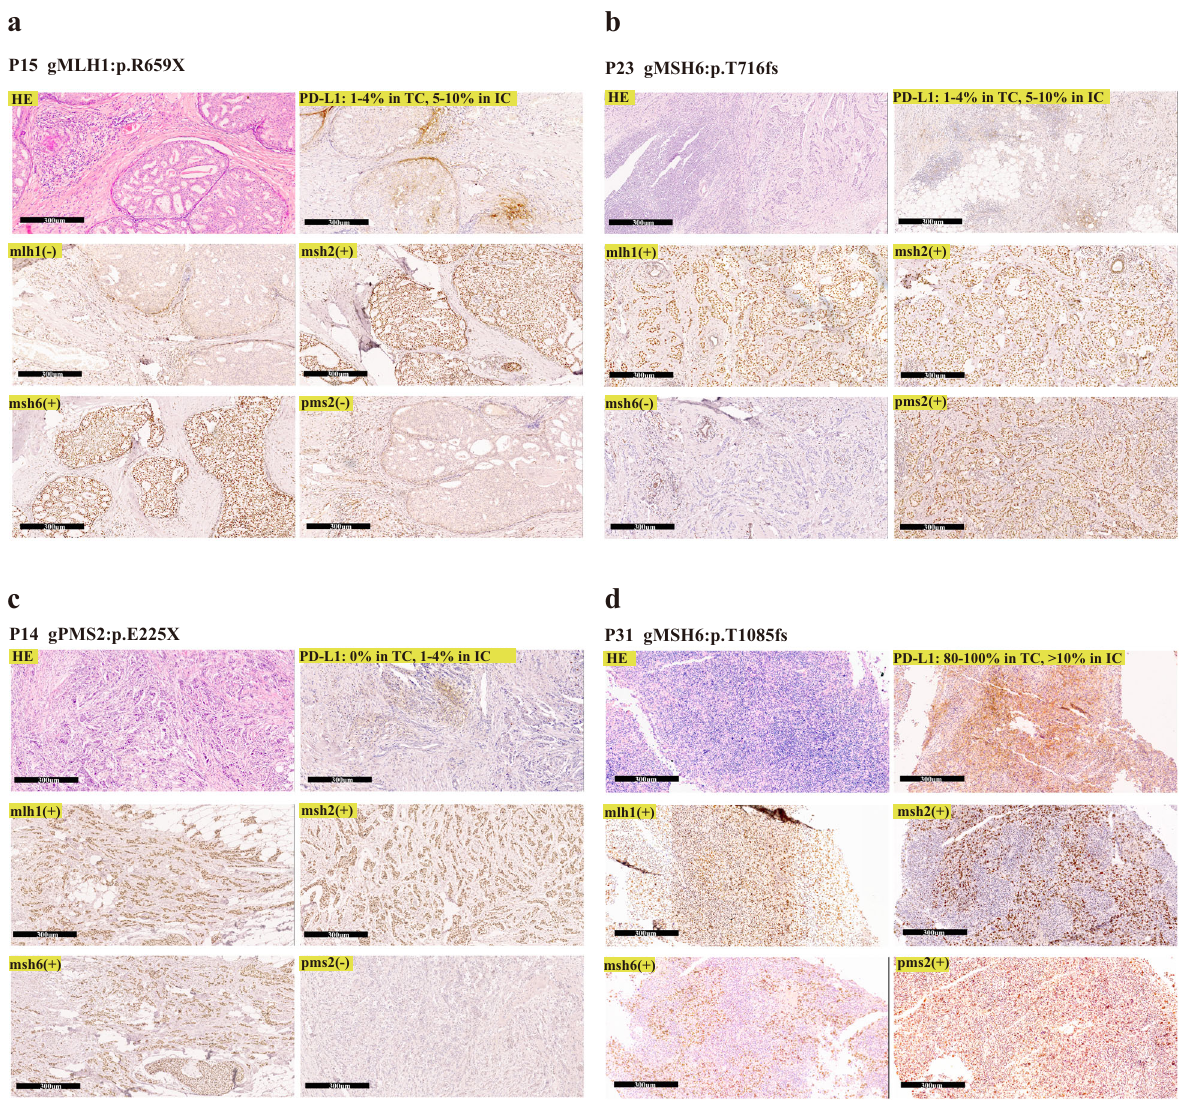
Fig. 2 H&E, PD-L1 protein and MMR protein immunostaining of breast cancers from MMR variant carriers. a MLH1 variant carrier, mlh1 and pms2 protein loss; b MSH6 variant carrier, msh6 protein loss; c PMS2 variant carrier, pms2 protein loss; d MSH6 variant carrier, strong pd-l1 protein expression. All scale bars = 300